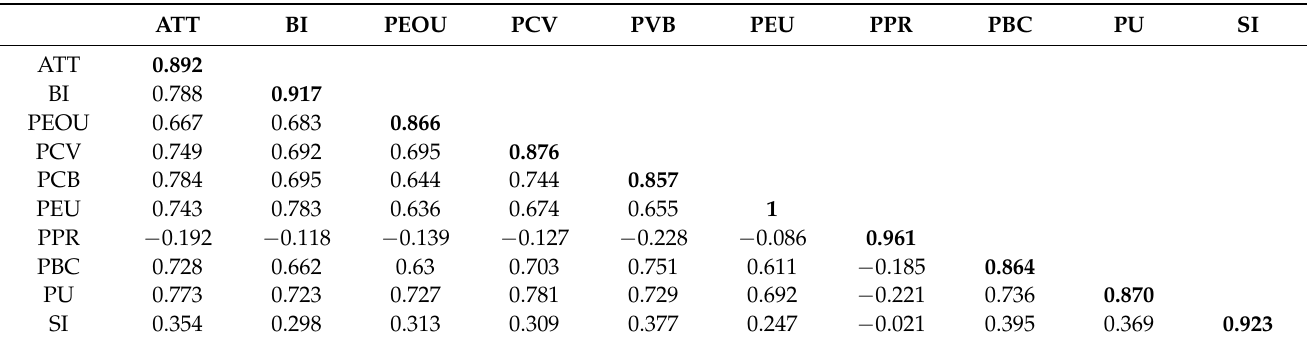
Table 5. Square root of the AVE (in bold) and correlation coefficients between constructs.